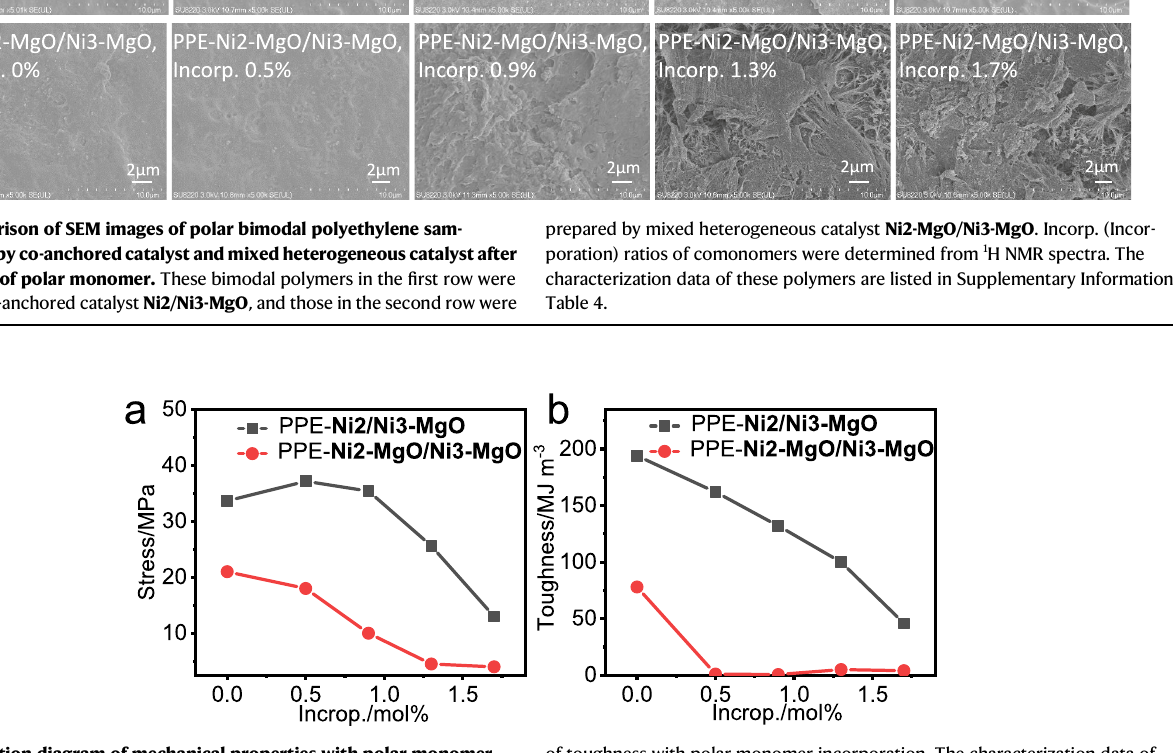
of toughness with polar monomer incorporation. The characterization data of these polymers are listed in Supplementary Information Table